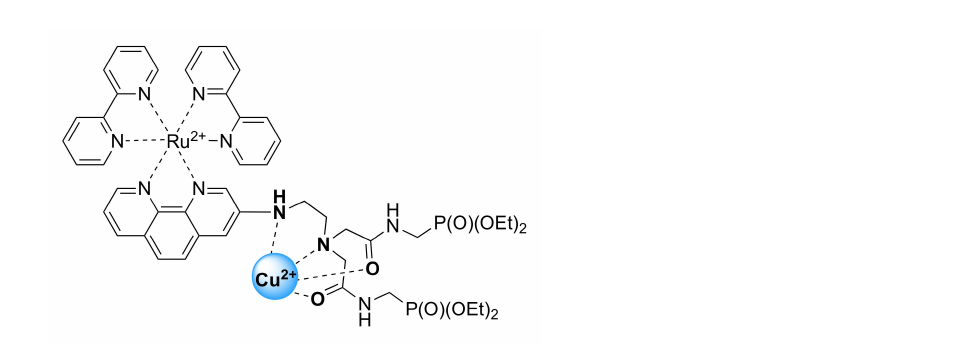
Figure 7. Schematic presentation of binding mode of Ru(N 2 P 2 phen) ligand in coordination shell of copper(II)